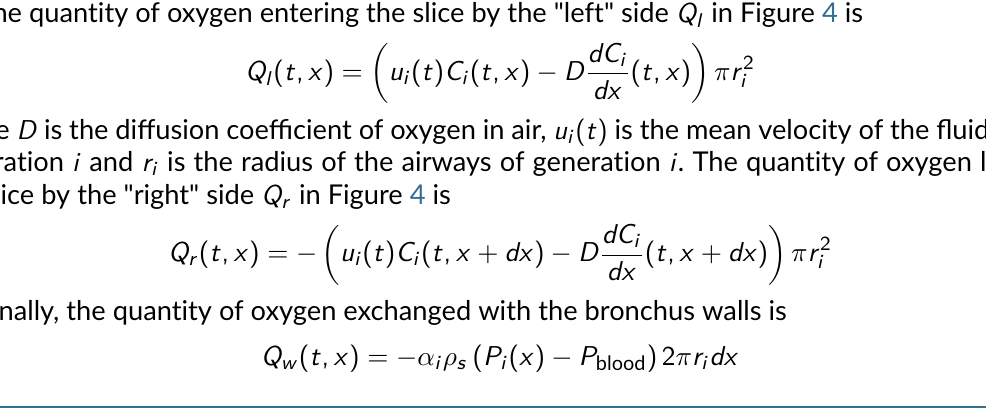
Figure 4 – Mass balance in a slice of an idealized airway (cylinder). The variation of oxygen concentration in the slice depends on the balance between the oxygen flow entering the slice and getting out of the